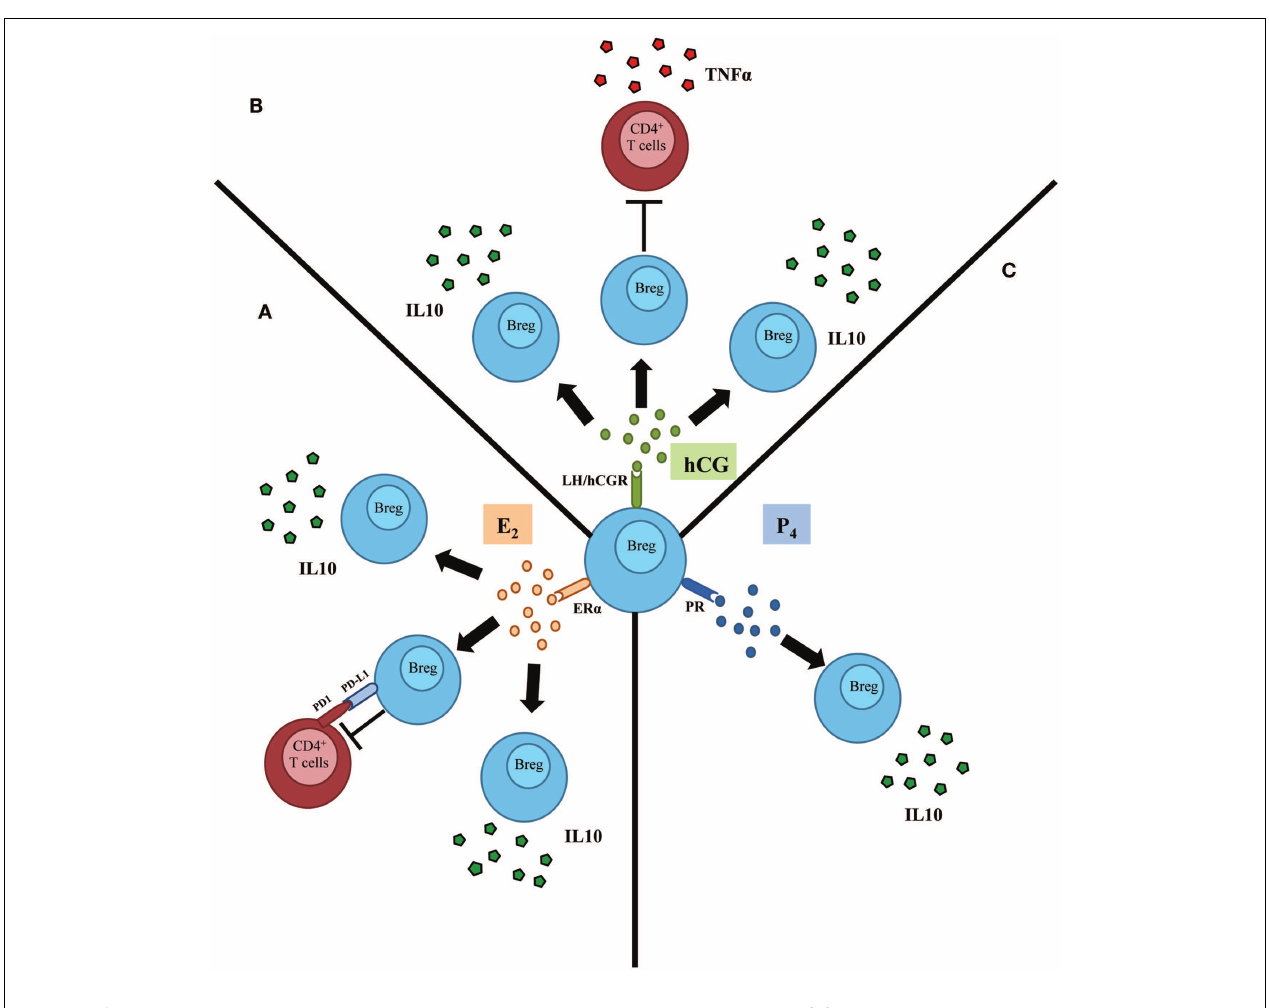
FIGURE 1 | Schematic representation depicting the influence of female sex hormones in the activation and subsequent function of regulatory B cells (Bregs) . (A) Estradiol (E2), acting through estradiol receptor alpha (ER α ), induces the proliferation as well as the production of IL-10 by regulatory B cells (Breg). In addition, E2 mediates the control ofT cells’ activation by B cells throughout a mechanism involving